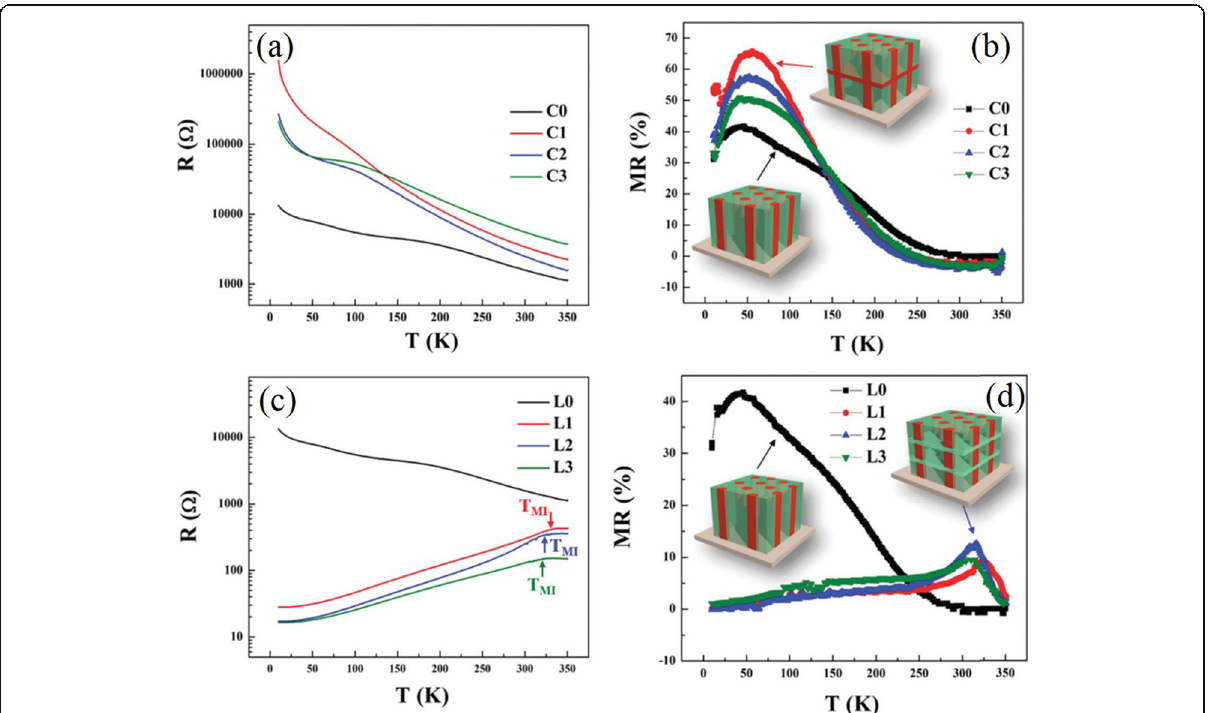
Fig. 40 a R – T plots of 3D CeO 2 framed nanocomposite thin films C0 — C3. b The temperature dependence of MR for the nanocomposite thin films C0 – C3. c R – T plots of 3D La 0.7 Sr 0.3 MnO 3 (LSMO) framed nanocomposite thin films L0 – L3. The arrows point out the metal-to-insulator transition temperature